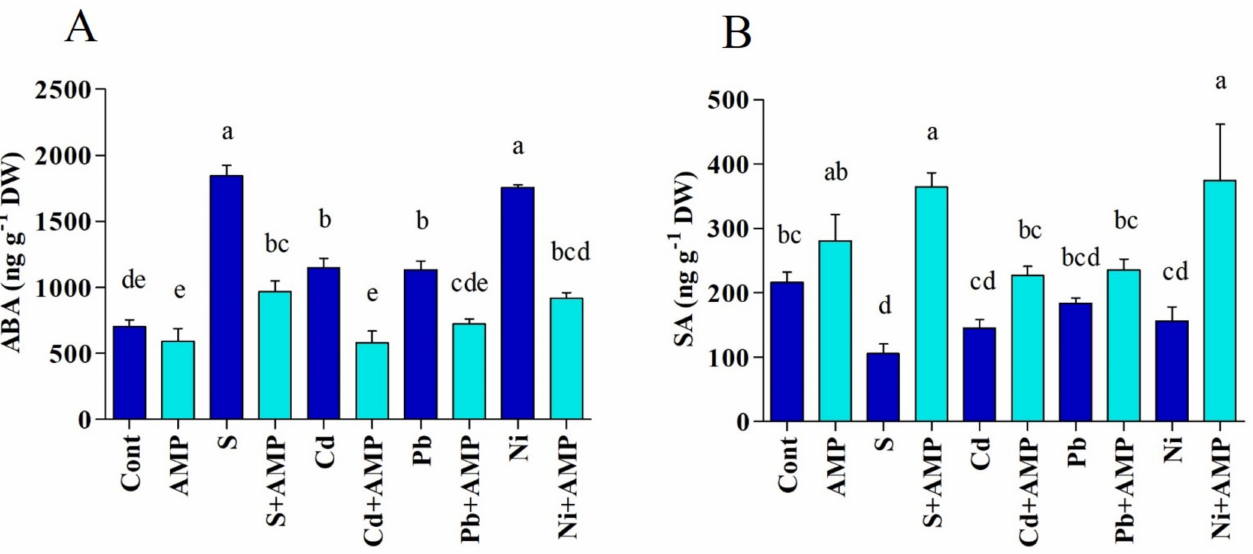
Figure 3. ( A ) ABA and ( B ) SA content in leaves of soybean grown under normal and stress conditions and treated with ampelopsin for 12 days (12DAT). Treatments: Cont (control), AMP (1 µ M ampelopsin), S (1.5 % sodium chloride), AMP (1 µ M ampelopsin) + S (1.5 % sodium chloride), Cd (3 mM cadmium), 1 µ M AMP (ampelopsin) + Cd (3 mM cadmium), Pb (3 mM lead), AMP (1 µ M ampelopsin) + Pb (3 mM lead), Ni (3 mM nickel), and AMP (1 µ M ampelopsin) + Ni (3 mM nickel). Values show the means ± SE ( n = 5) and significant differences at p < 0.05 (Tukey test). Bars with different lowercase letters are significantly different from each